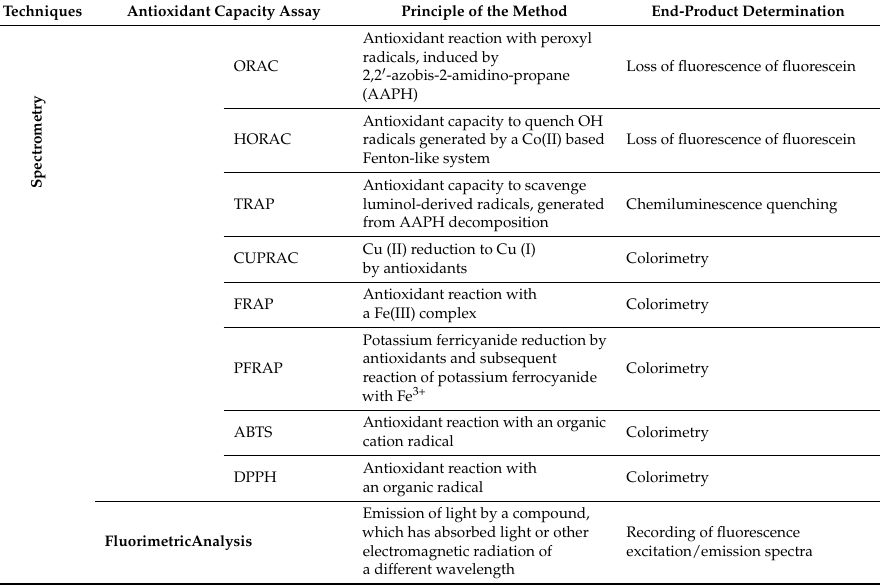
Table 2. Different techniques used to measure antioxidant activity.